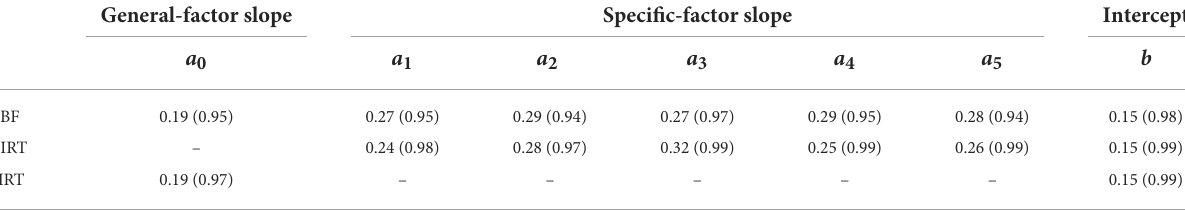
TABLE 5 ARMSE (ACor) values for the estimation of the item slope and intercept parameters in the three models: FIBF, between-item MIRT, and UIRT. General-factor slope